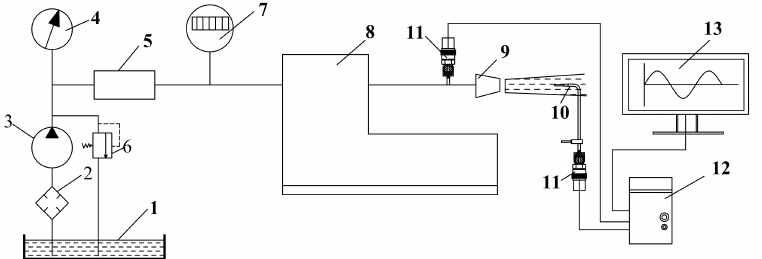
Figure 2. Device schematic of pressure measurement system. 1—Water tank; 2—Strainer; 3—Plunger pump; 4—Pressure gauge; 5—Surge tank; 6—Overflow valve; 7—Turbine flowmeter; 8—Test board; 9—Nozzle; 10—Pitot tube; 11—Pressure transmitter; 12—Data recording card and